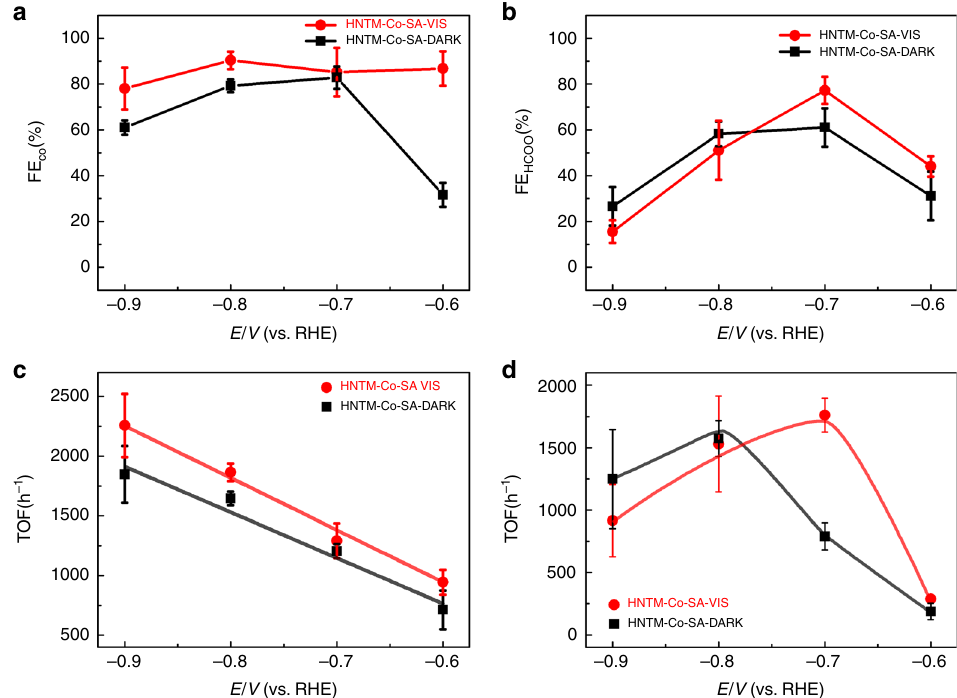
Fig. 4 Photo-coupled electrochemical and electrochemical reduction of CO 2 . a FE CO on HNTM-Co-SA under visible light (red line)/dark (black line). b FE HCOO − on HNTM-Cu-SA under visible light (red line)/dark (black line). c TOF curves of HNTM-Co-SA under visible light (red line)/dark (black line). d TOF curves of HNTM-Cu-SA under visible light (red line)/dark (black line). Error bars are ±